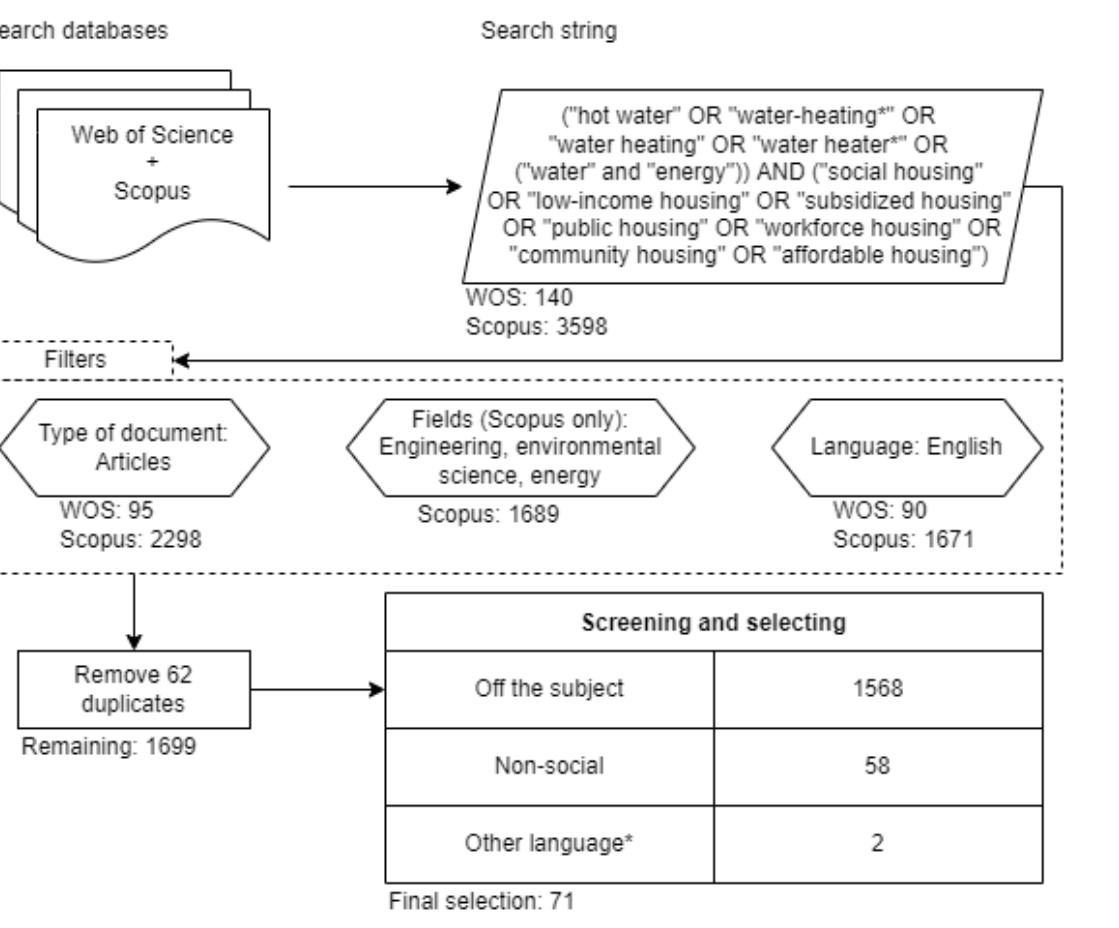
Figure 1. Flowchart of the search and selection methodology.